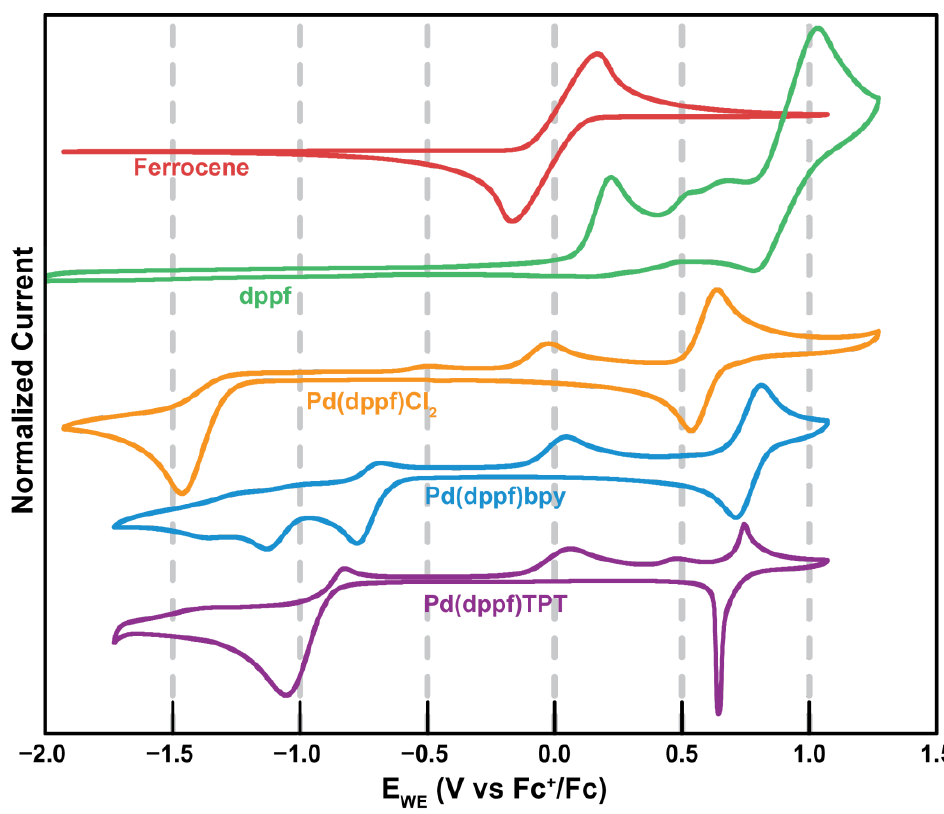
Figure 3. Cyclic voltammograms of Fc-containing compounds (5.0 mM Fc, 1.0 mM dppf, 1.0 mM Pd(dppf)Cl 2 , 1.0 mM Pd(dppf)bpy, 0.30 mM Pd(dppf)TPT at 100 mV ∙ s − 1 in DCM (100 mM TBAPF 6 ).